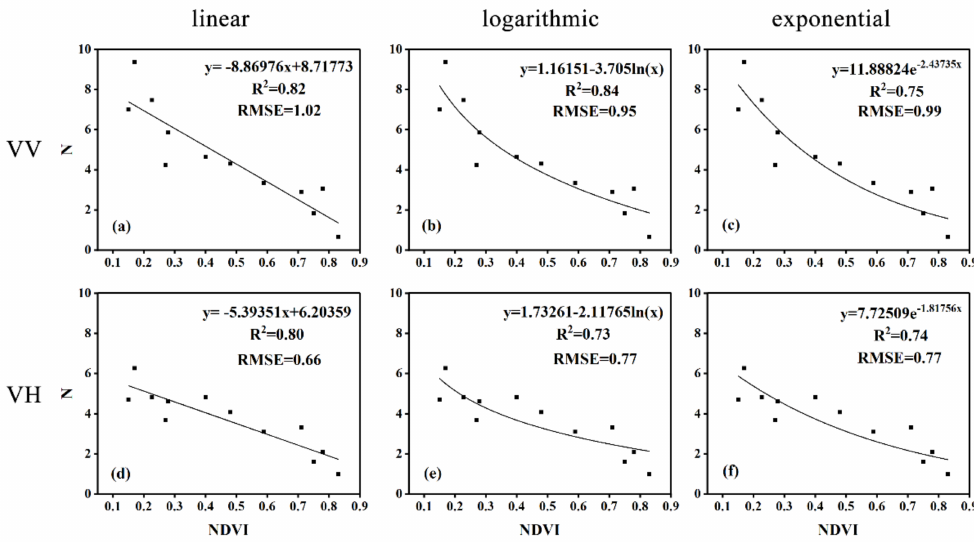
Figure 6. Regression relationship between N and NDVI for VV and VH polarization. ( a ) and ( d ): linear; ( b ) and ( e ): logarithmic; and ( c ) and ( f ):